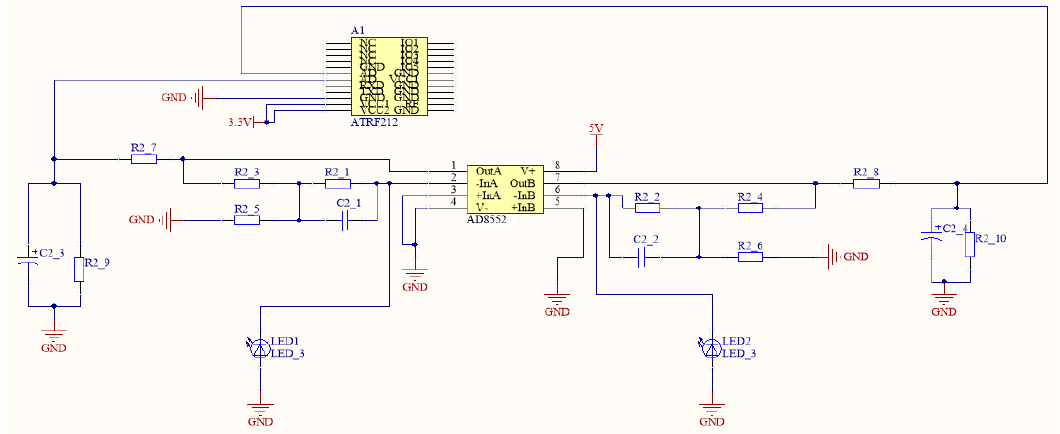
Figure 10. Principles used in the sensor signal processing circuit.